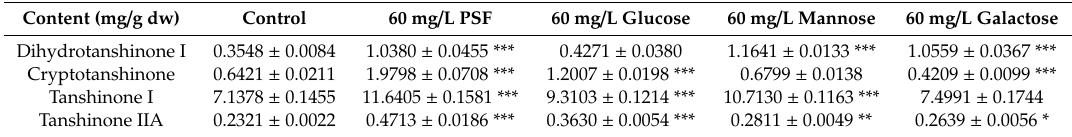
Figure 1. GC-MS analysis of D16 PSF monosaccharides components. ( a ) GC-MS chromatogram of monosaccharide standards; ( b ) GC-MS chromatogram of the D16 PSF sample. The numbers 1 to 7 represented the rhamnose, arabinose, xylose, fructose, mannose, glucose, and galactose, respectively. D16 PSF means polysaccharide fraction from T. atroviride D16. Table 1. The e ff ects of D16 PSF and its monosaccharide constitutes on tanshinones accumulation on the fourteenth